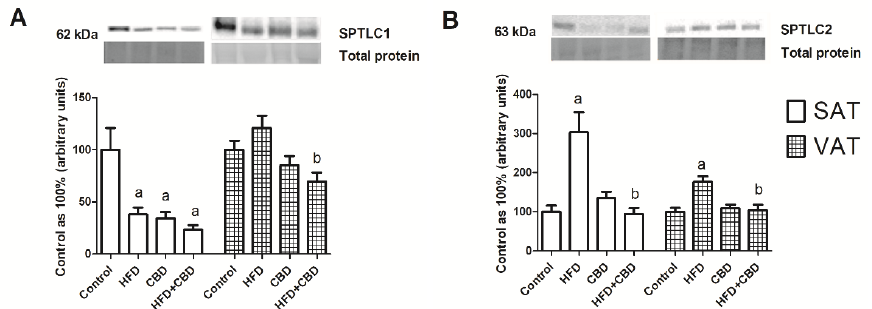
Figure 2. The total expression of proteins from de novo sphingolipid synthesis, e.g., ( A ) serine palmitoyltransferase, long-chain base subunit 1 (SPTLC1) and ( B ) serine palmitoyltransferase, long-chain base subunit 2 (SPTLC2), in the subcutaneous (SAT) and visceral (VAT) adipose tissues of rats fed a standard diet (control) or high-fat diet (HFD) after chronic CBD treatment. The total expression of the above proteins was standardized to the total protein expression, and the control group was set to 100%. The data are expressed as mean values ± SD, n = 6 in each group. a p < 0.05: significant difference: control group vs. experimental group; b p < 0.05: significant difference: HFD vs. HFD+CBD.